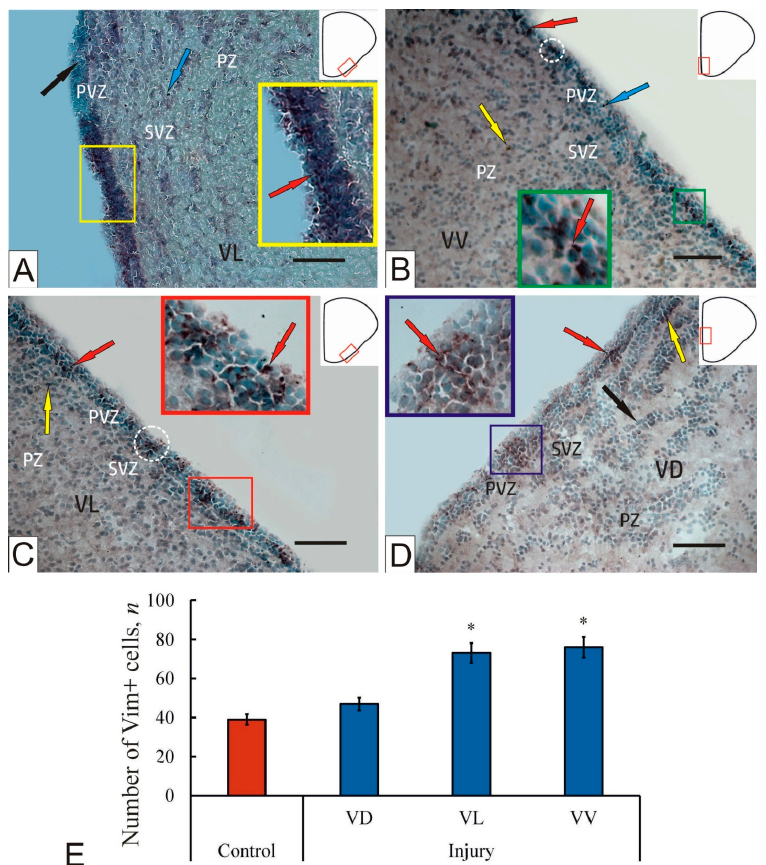
Figure 3. A representative image of Vim-immunolabeling in the subpallial region of the intact telencephalon ( A ) of a juvenile Oncorhynchus masou and at 1 week after the traumatic injury ( B – D ) to the telencephalon: ( A ) localization of Vim in intact subpallium, immunopositive cells (inset, red arrows) and granules (blue arrow) in the parenchymal zone (PZ), and Vim– cells(black arrow); ( B ) Vim+ cell conglomerates (inset) and clusters (white dashed oval) of intensely Vim-labeled cells (red arrow) and moderately Vim-labeled cell (yellow arrow) in PZ of VV at 1 week post-injury, and Vim+ granules (blue arrow); ( C ) post-traumatic reorganization of Vim-immunopositivity in VL, Vim+ heterogeneous conglomerates in PVZ and SVZ (an enlarged fragment is shown in the inset), alternating with immuno-negative regions,Vim+ cells clusters in PVZ (white dashed oval), intensely Vim-labeled cells (red arrows), and moderately Vim-labeled cells (yellow arrow); ( D ) weakly labeled Vim+ cells after injury in the PVZ of VD (inset), moderately labeled cells (yellow arrow), intensely labeled fibers (red arrows), and Vim– cell (black arrow); ( E ) the quantitative ratio of Vim+ cells in intact animals (control group) and at 1 week post-injury ( n = 5 in each group, * P ≤ 0.05; significant difference vs. control). Student–Newman– Keuls test.Immunohistochemical labeling of vimentin in combination with methyl green staining. Scale bar: 100 µm.